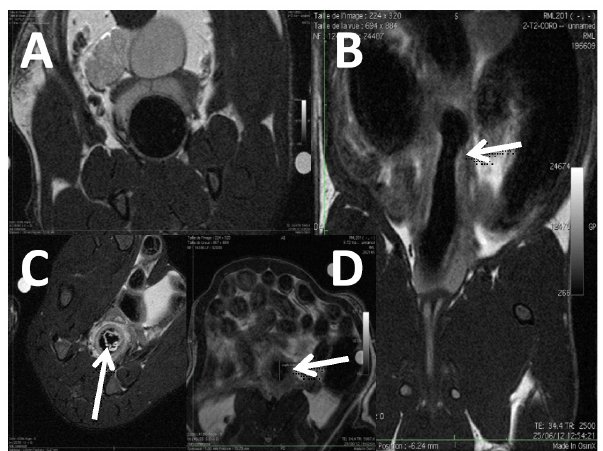
Figure 2. MRC of rats, T2w abdominal images. Chronic colitis was induced by weekly intrarectal injection of TNBS for 6 weeks. MRC was performed 1 week after the last injection. (A) Axial image of a control rat: colon wall is thin and regular. (B) Coronal image of a chronic TNBS rat: the arrow indicates stenosis with prior dilatation. (C) Axial image of a TNBS rat (T2w with fat suppression): the arrow indicates colon mucosal detachment. (D) Axial image of a TNBS rat: the arrow indicates colon wall thickening.